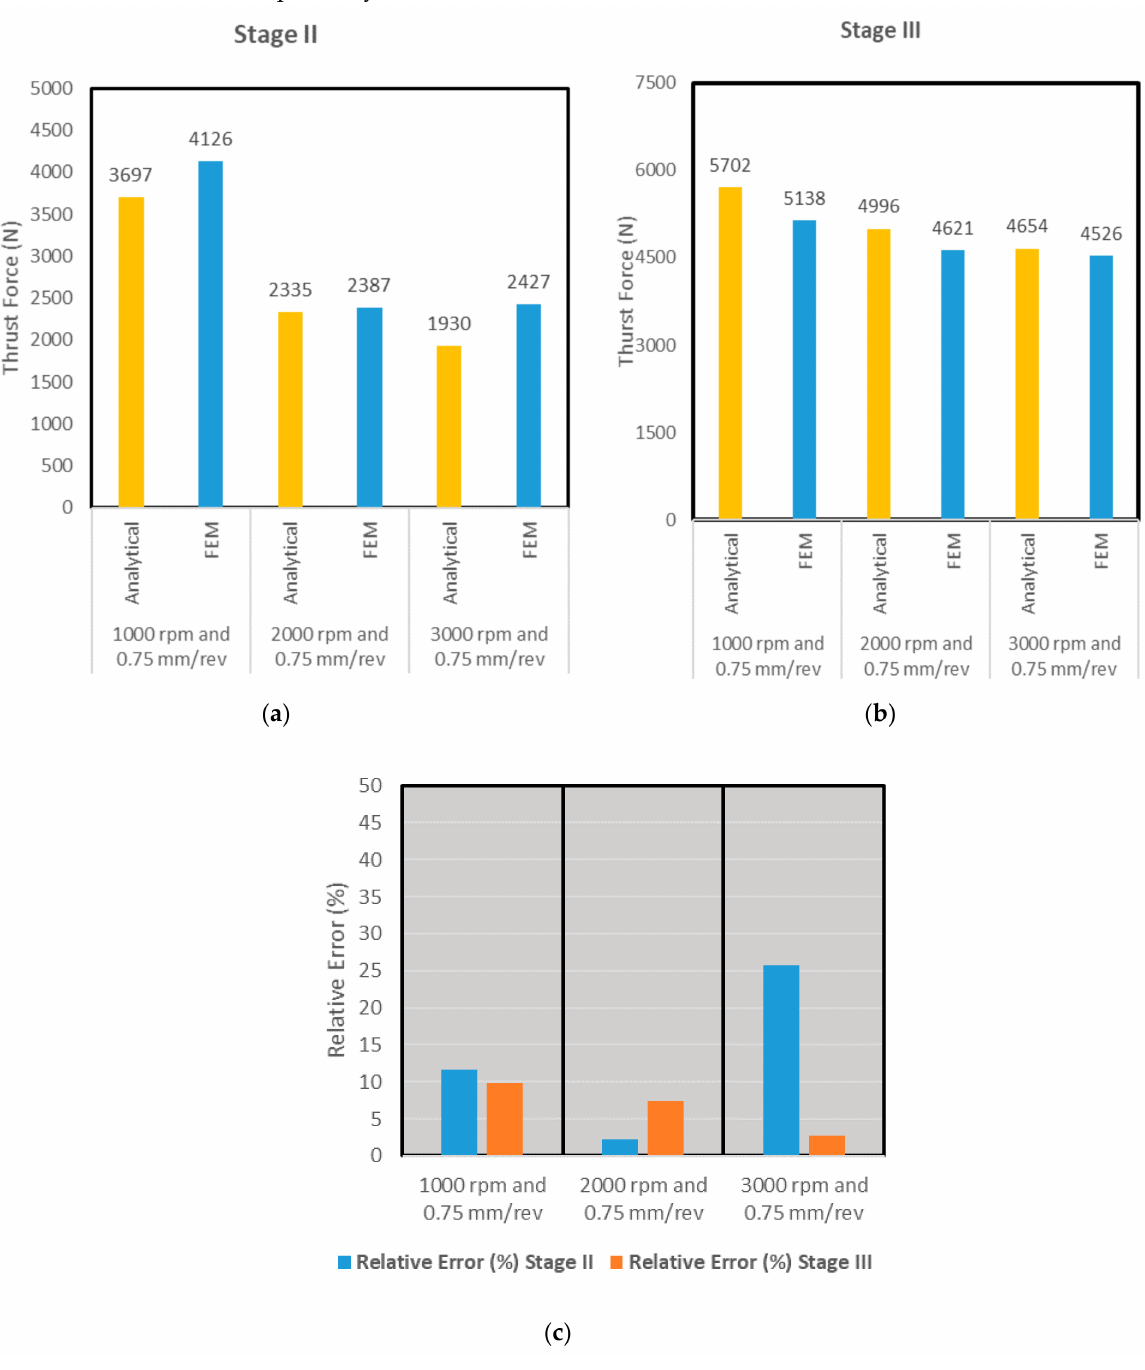
Figure 14. ( a ) Stage II: Average thrust forces in analytical and FEA approaches ( b ) Stage III: Average thrust forces in analytical and FEA approaches ( c ) Relative error % in both